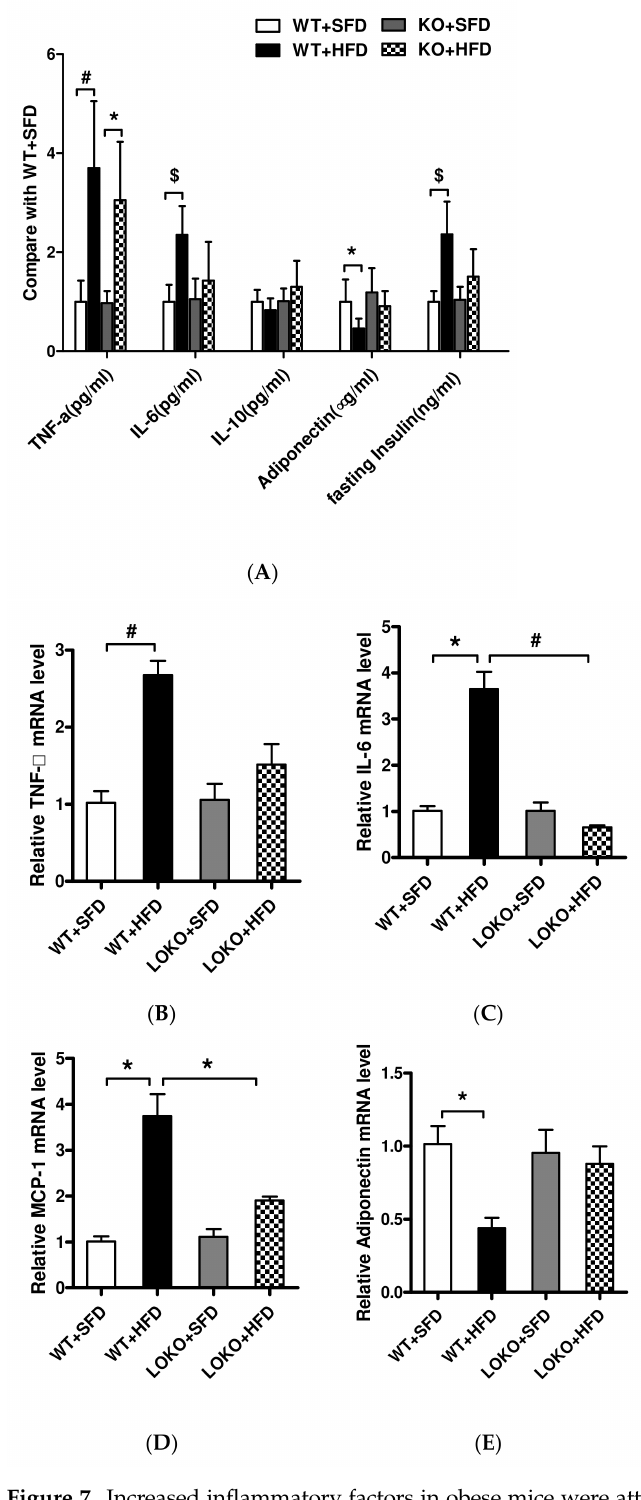
Figure 7. Increased inflammatory factors in obese mice were attenuated in LOKO mice. ( A ) Serum adipokine and insulin level was measured according to manufacturer’s instructions. WT HFD mice showed reduced adiponectin, increased TNF- α , IL-6, and insulin in comparison with other groups. Data represented as fold over WT control (mean ± SEM, * p < 0.05, # p < 0.01, $ p < 0.001 vs. WT + SFD or KO + SFD). ( B – E ) Total RNA isolated from kidney sections was used to analyze expression of inflammatory genes by RT-qPCR from obesity (HFD) and control (SFD) WT and LOKO mice, and is expressed as fold over WT + SFD control. Values are shown as mean ± SEM ( n = 3). * p < 0.05, # p <